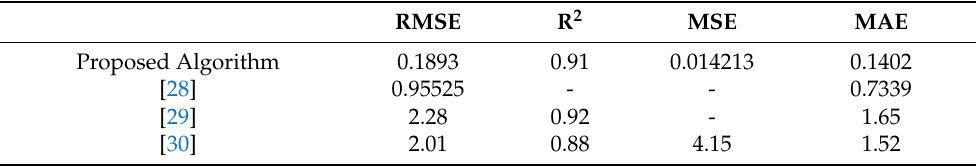
Table 5. Performance comparison table with previous studies.